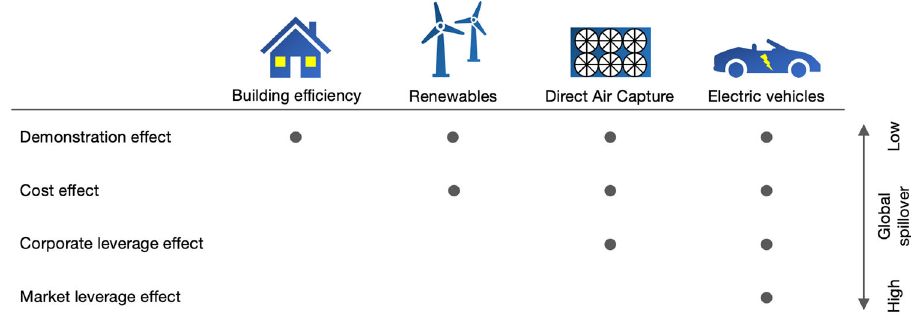
Fig. 3 Global effects in technology transitions. The global leverage of climate leaders in technology transitions varies by how interdependent technology markets are. Depending on the level of interdependence, the spillovers of policy in a fi rst-mover country to market actors in a follower country are more or less comprehensive. In all low-carbon transitions, climate leaders can create demonstration effects and often reduce the cost of technology for follower countries. In some cases, they can also in fl uence follower markets through corporate leverage and market leverage